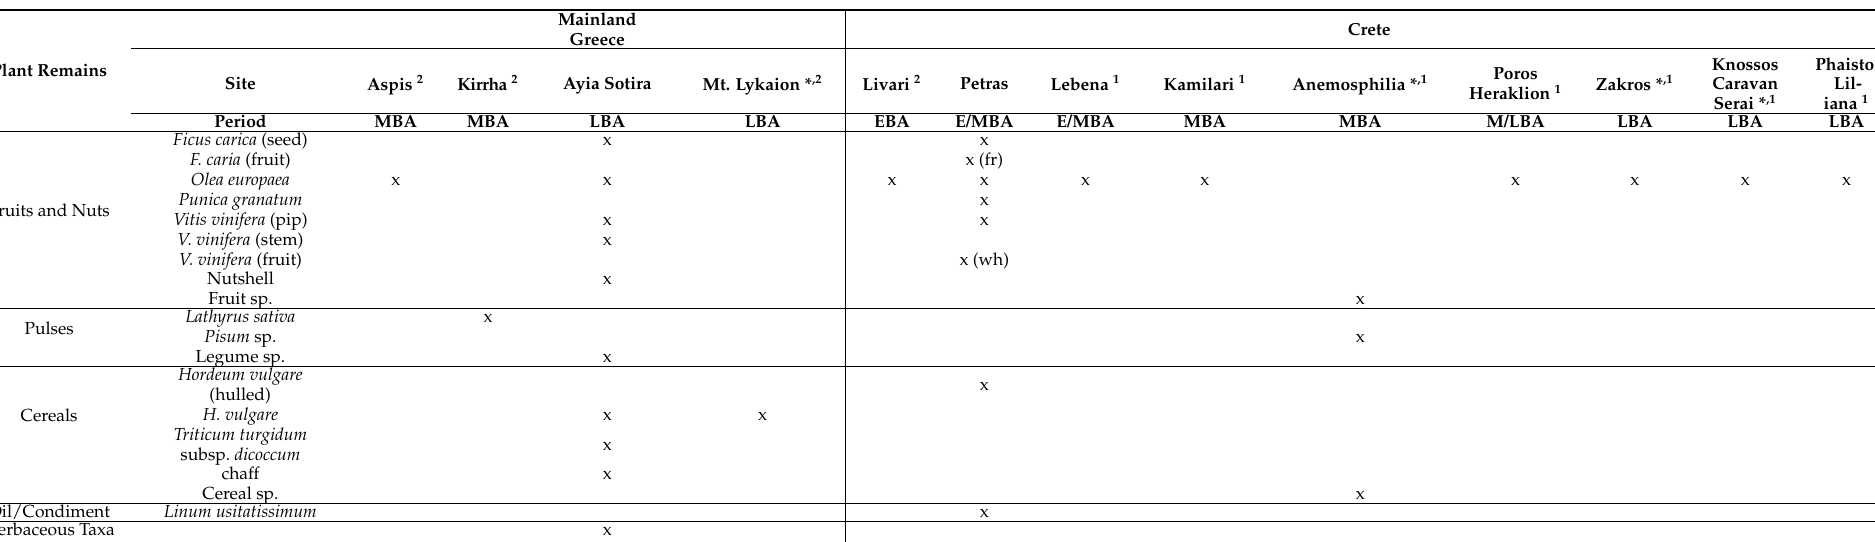
Table 6. Published archaeobotanical records for Bronze Age ritual sites/contexts on Crete and Mainland Greece (Aspis and Kirrha: Margaritis 2014a; Ayia Sotira: Smith et al. 2014; Kotzamani and Livarda 2017; Mt. Lykaion: Margaritis 2014b; Livari: Margaritis 2014a; Petras: Margaritis 2017; Lebena: Daux 1960; Kamilari: Levi 1976; Anemosphilia: Sakellarakis and Sapouna-Sakellarakis 1981; Poros Heraklion: Lembesi 1967; Zakros: Platon 1971; Knossos Caravan Serai: Evans 1964; Phaistos Liliana: Savignoni